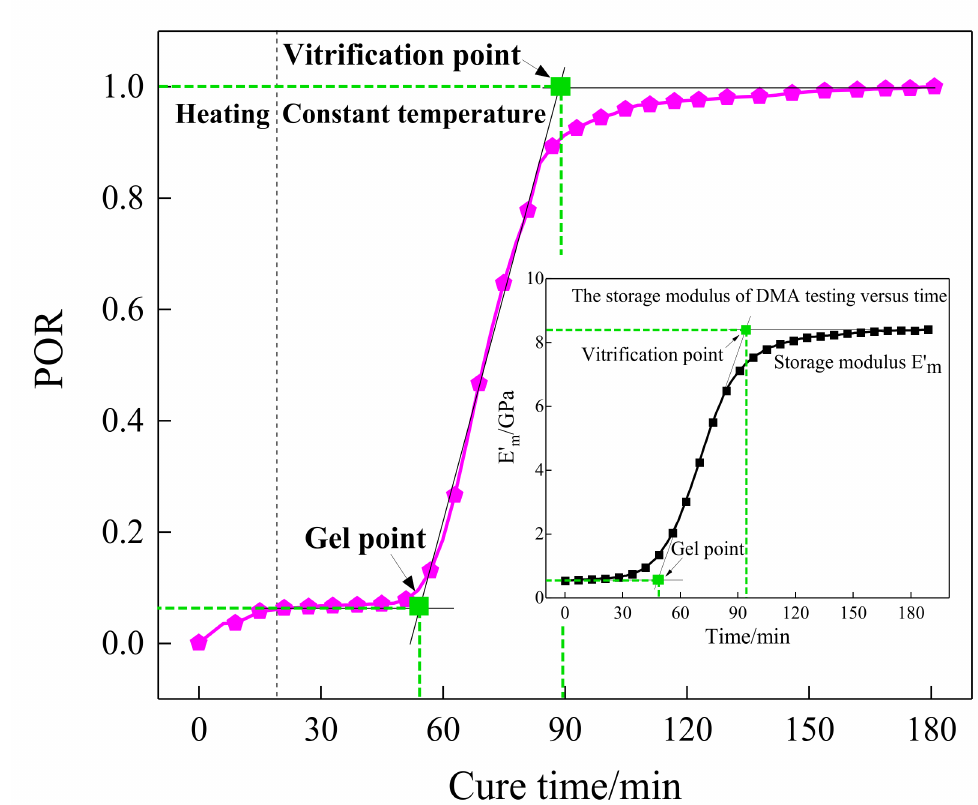
Figure 8. The POR curve of path P7_4 versus curing